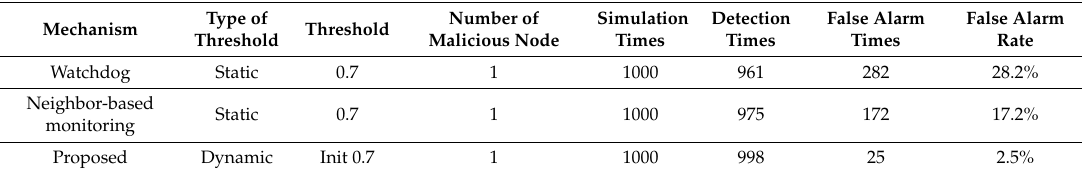
Figure 9. Forward probability of the network with one malicious node.